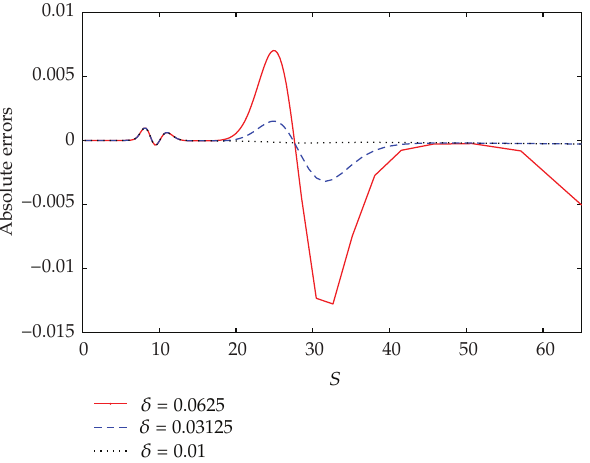
Figure 4: Absolute errors with several values of δ and a fixed h